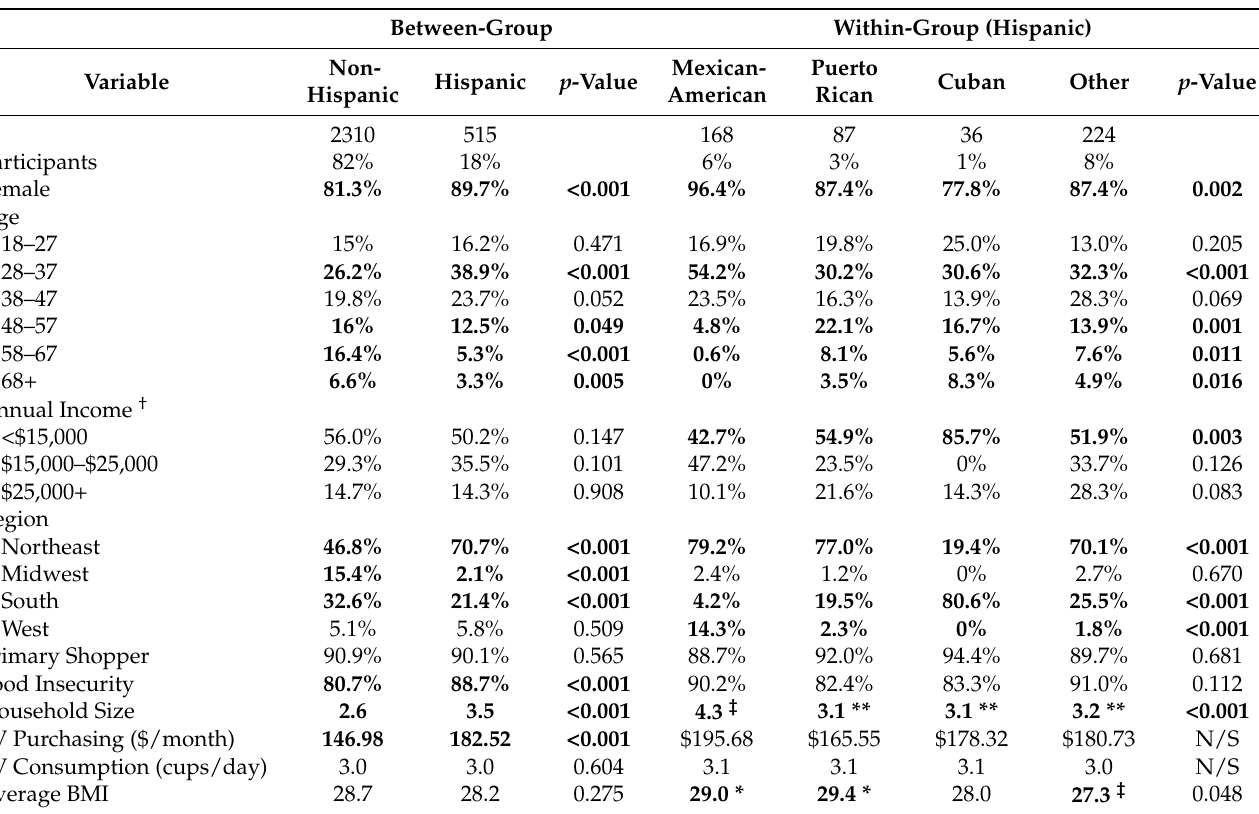
Table 1. Descriptive Statistics and Between- and Within-group Comparisons for Hispanics vs. non-Hispanics and His- panic